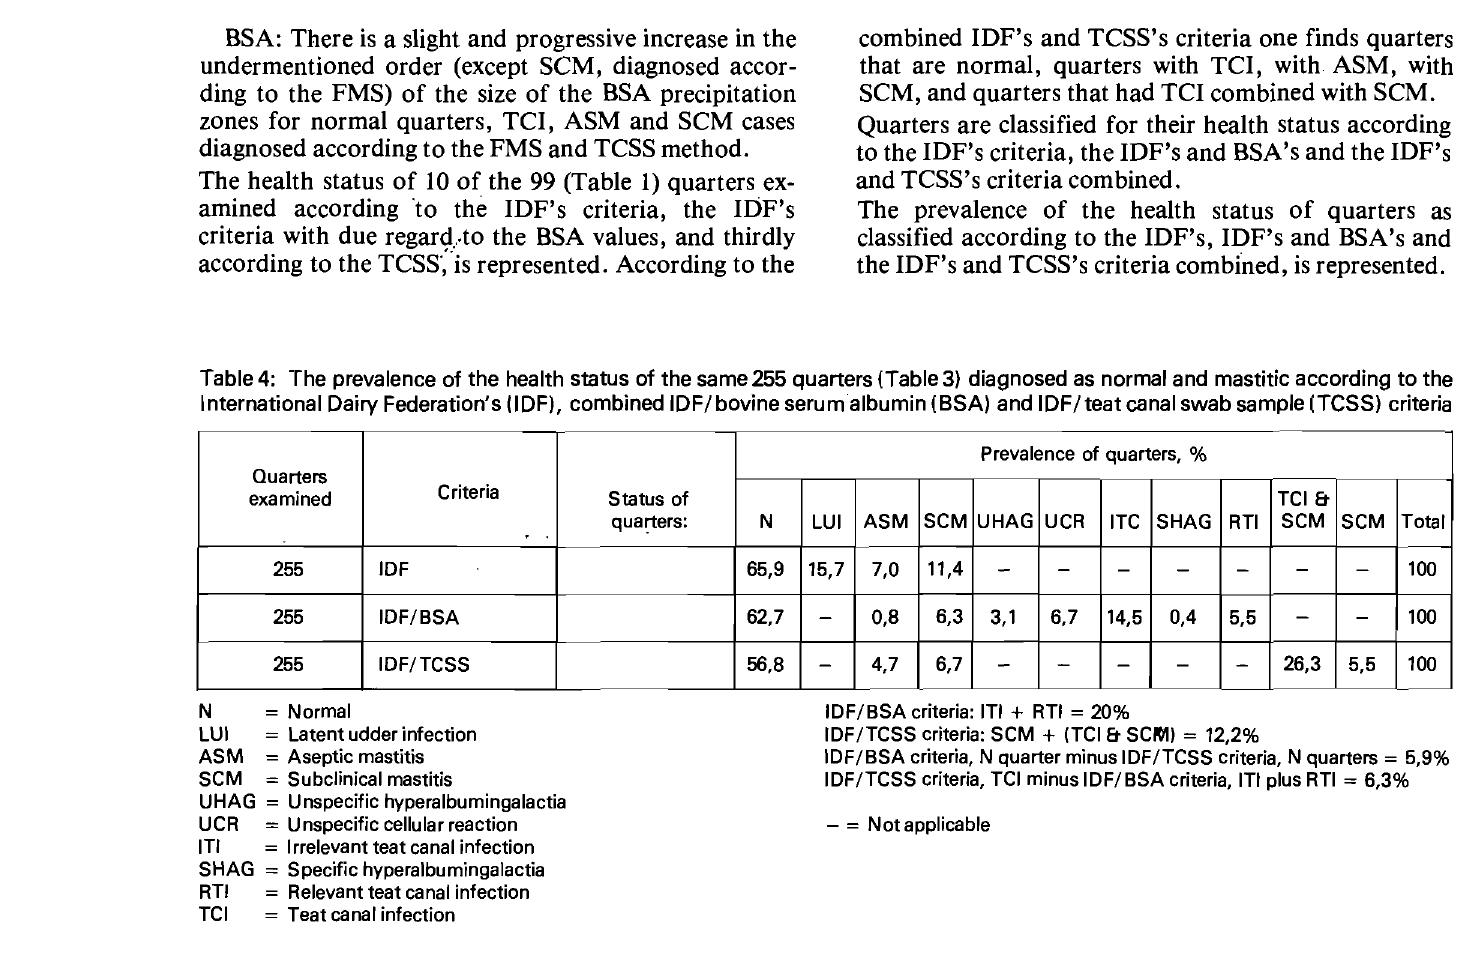
Table 5: Key for the differentiation between subclinical mastitis and other udder health states in normally lactating cows by means of somatic cell count (SeC), bacteriological and bovine serum albumin (BSA) determinations SCC